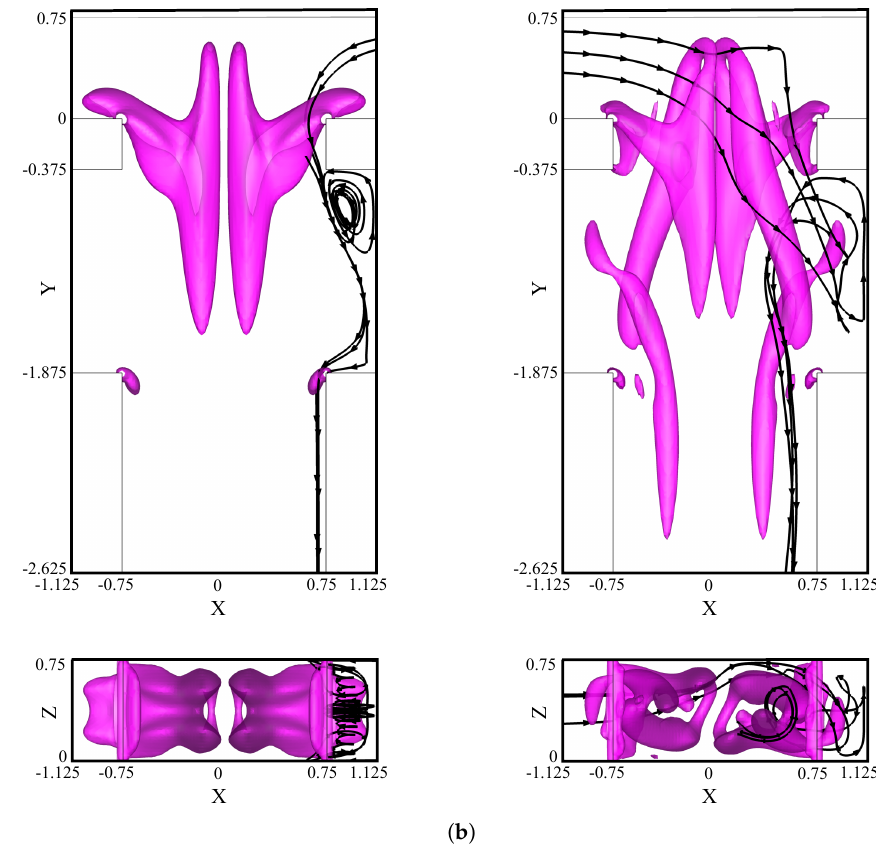
Figure 5. Top view and outlet view of the isosurfaces of the λ 2 vortex-indicator and streamlines inside the right cavity at ( a ) Re = 100 and ( b ) Re =